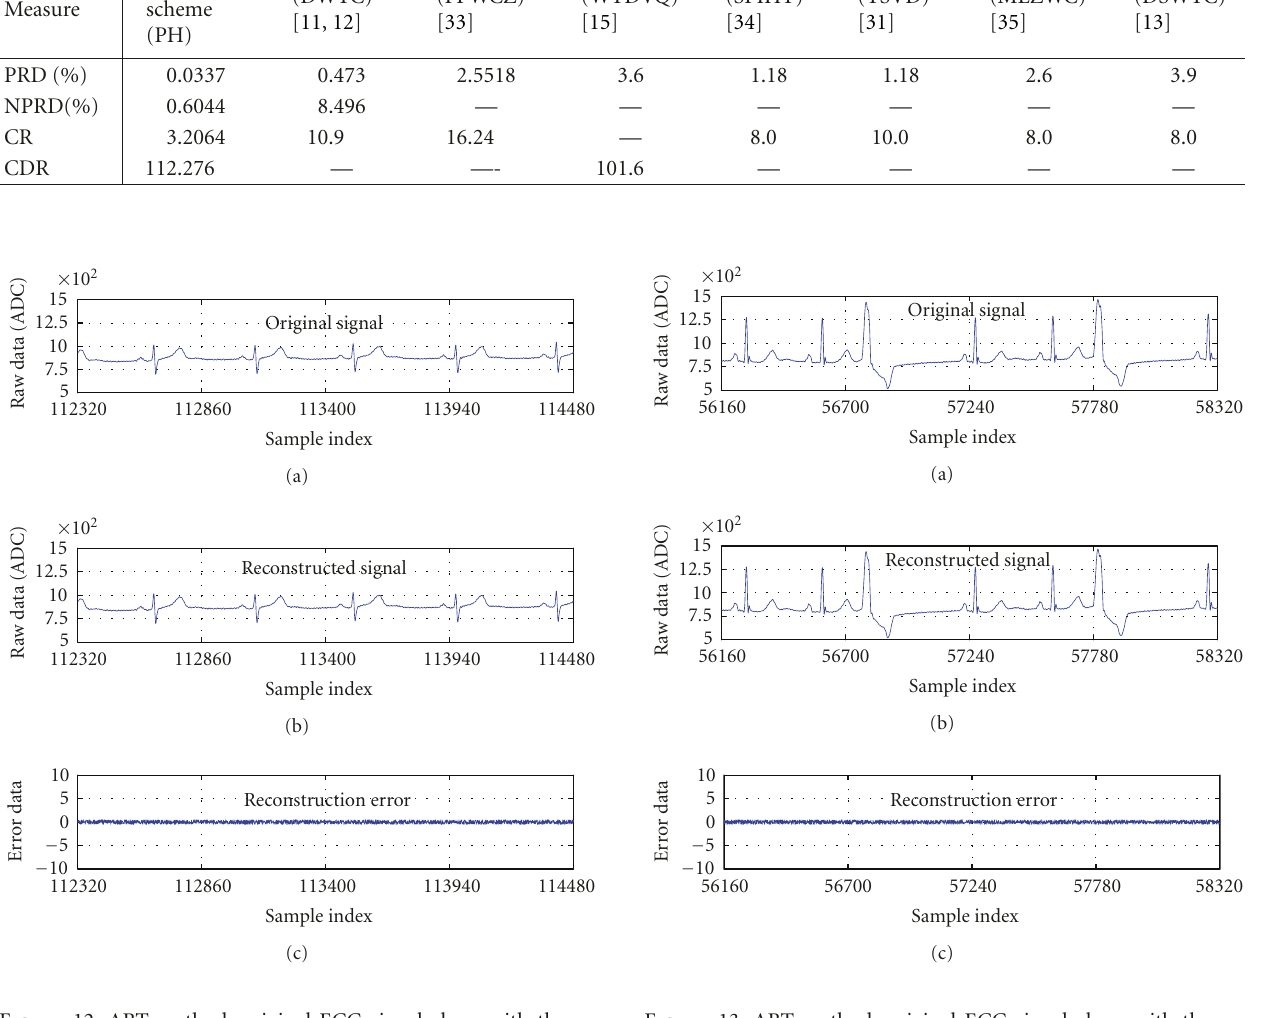
Figure 12: ABT method: original ECG signal along with the re- constructed and residue signals of MIT-BIH ADB record 117MLII . In the reconstructed signal, PRD = 0 . 0337, NPRD = 0 . 6044, SNR = 159 . 8987, RMS = 0 . 2888, CR = 3 . 2064 (PH), BPS = 3 . 7425 (PH), and CDR = 112 . 28 (PH).